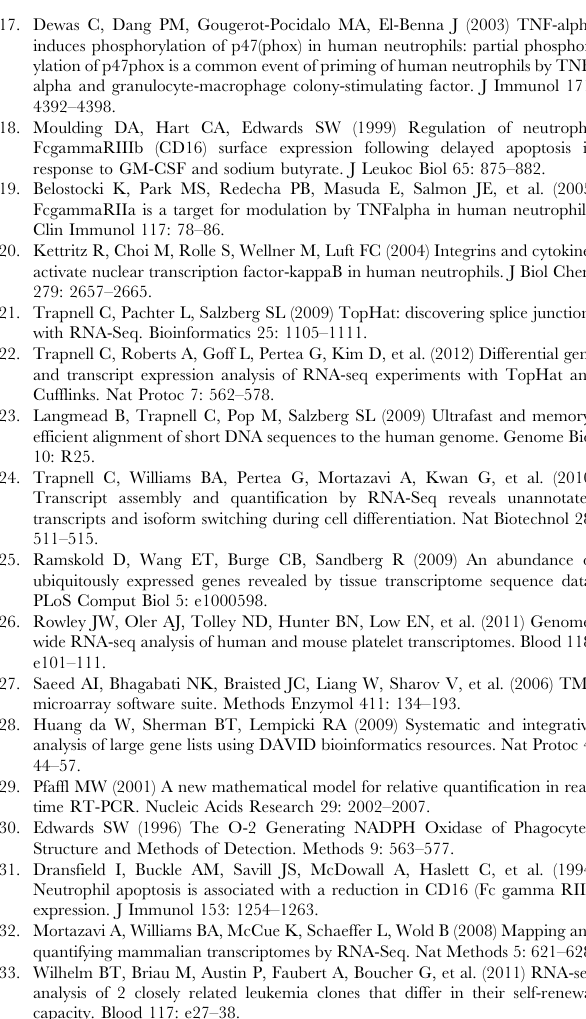
Table S1 Summary of sequencing read alignments . Illu- mina reads were mapped using default TopHat parameters, reporting only uniquely mapped reads. SOLiD reads were mapped using a modified protocol using Bowtie and TopHat as stated in Methods S1.